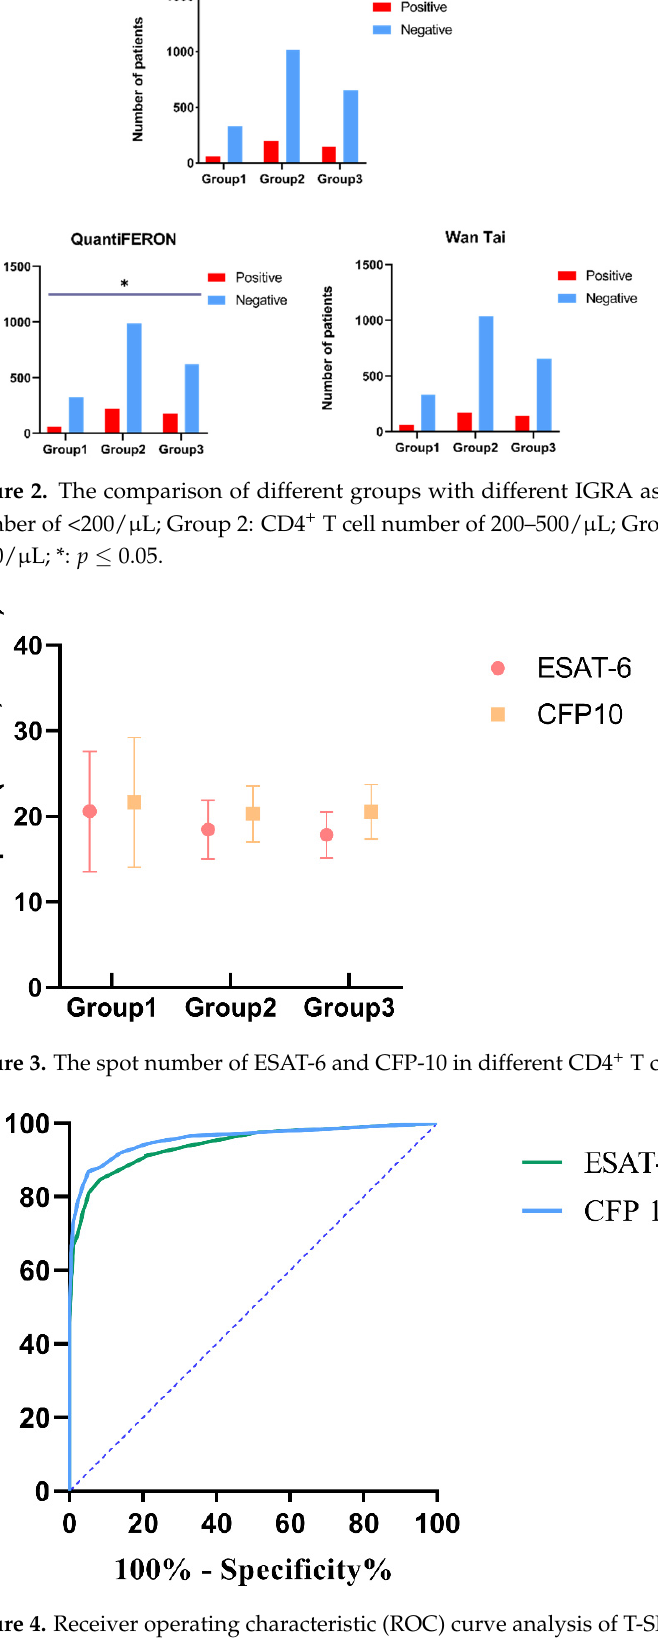
Figure 4. Receiver operating characteristic (ROC) curve analysis of T-SPOT.TB test.